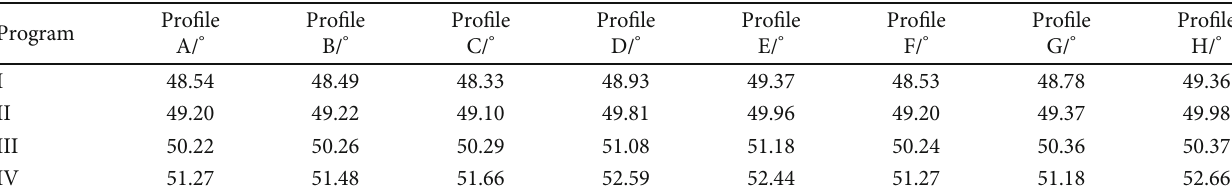
Figure 4: Pro fi le and geological model of open pit. (a) Pro fi le layout of open pit. (b) Geological model of pro fi le C. Table 2: Slope angle design